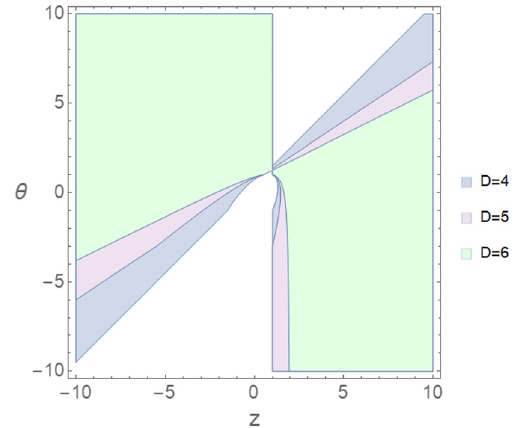
Fig. 5 The colored regions depict the physically admissible regions on the parameter space, this includes its solid boundaries. We exemplify with the D = 4 , 5 , 6 cases (blue, light purple, light green respectively). Other dimensions feature a similar behaviour except that the allowed area decreases for a greater D . Other ( z ,θ) combinations inside the